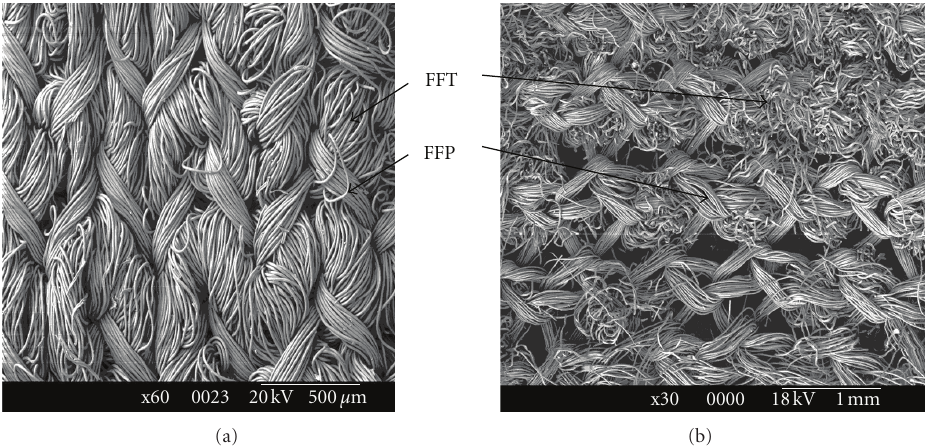
Figure 6: Scanning electron microscopy examination of Cooley Double Velours prosthesis: (a) virgin prosthesis, (b) explanted prosthesis, destruction of texturized